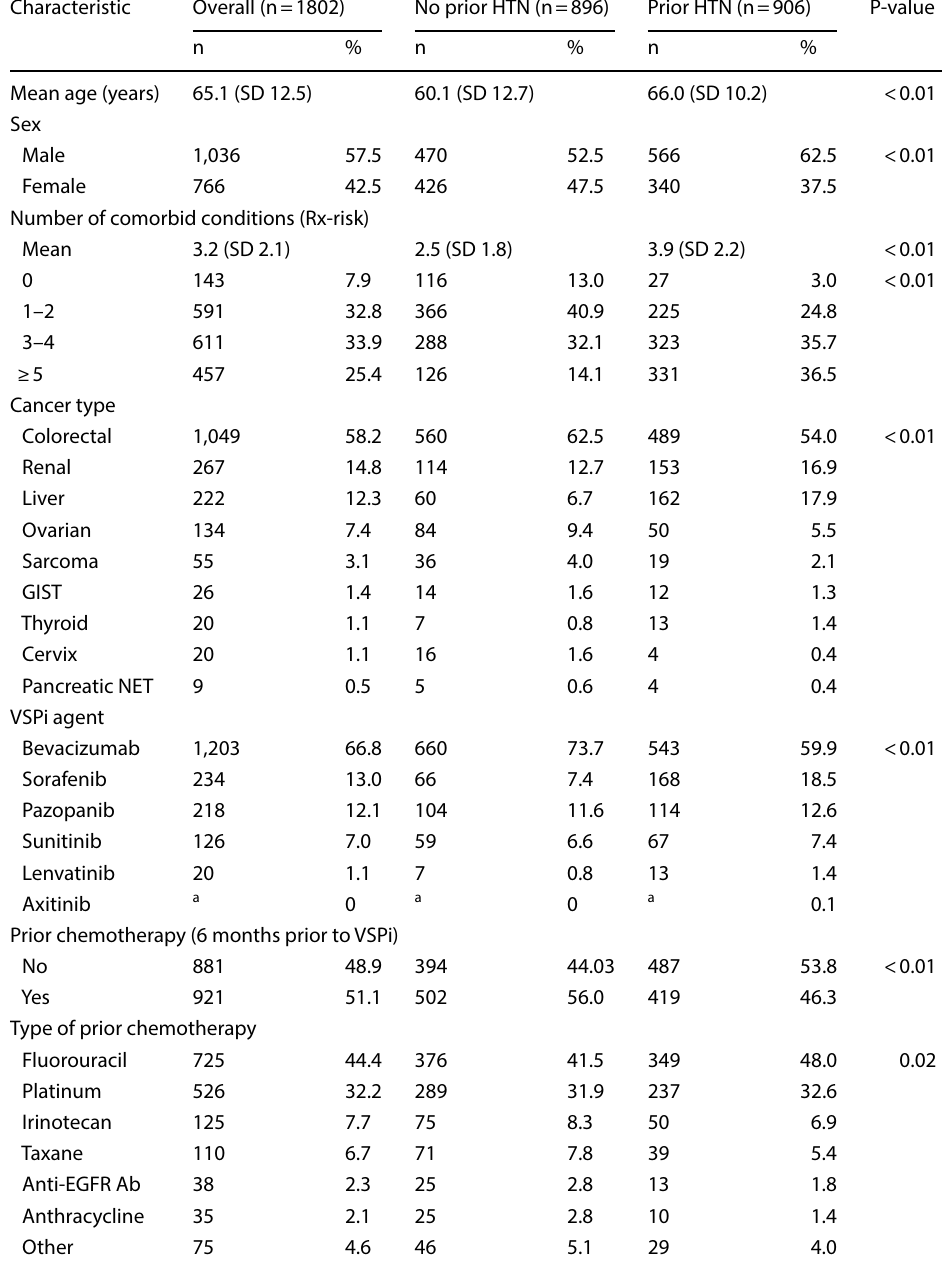
Table 1 Study population dispensed VSPi (n =